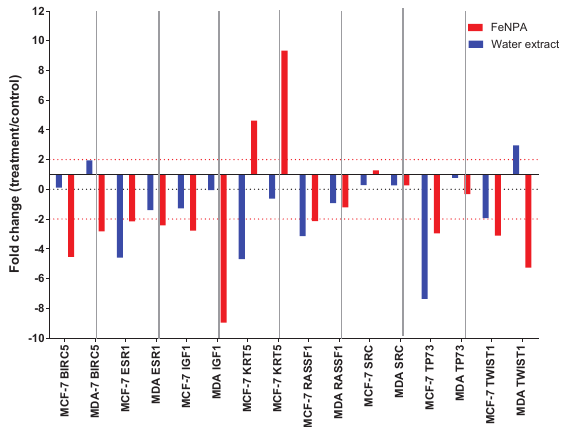
and ASP on gene expression in breast A